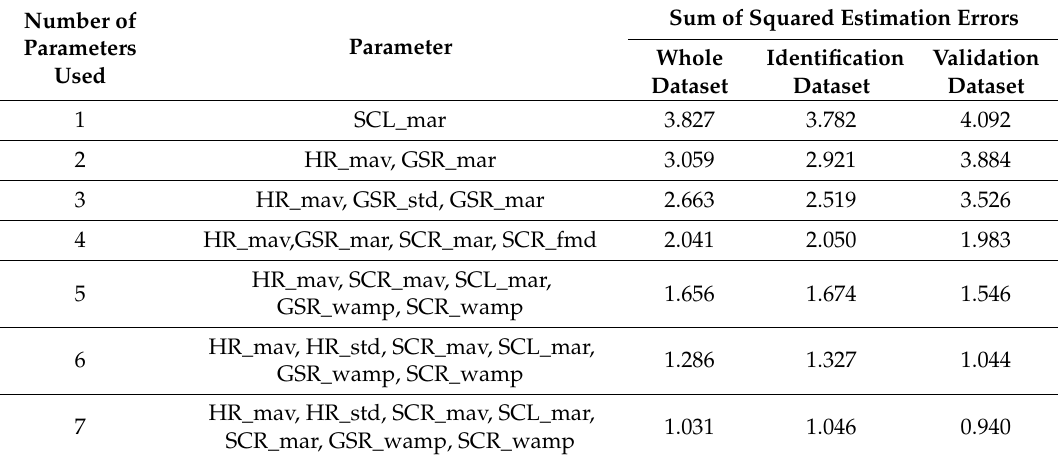
Table 5. Estimation performance for di ff erent number of selected features